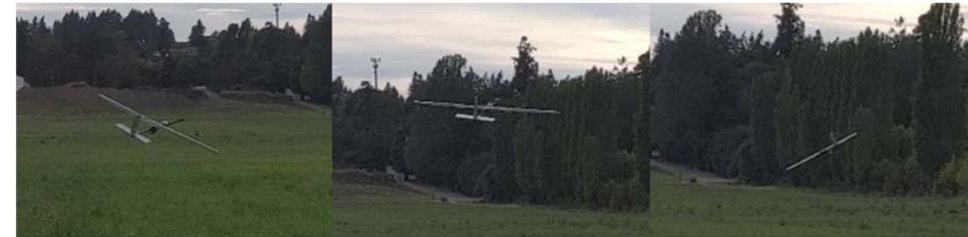
Figure 14. Morphing wing gliding flight.